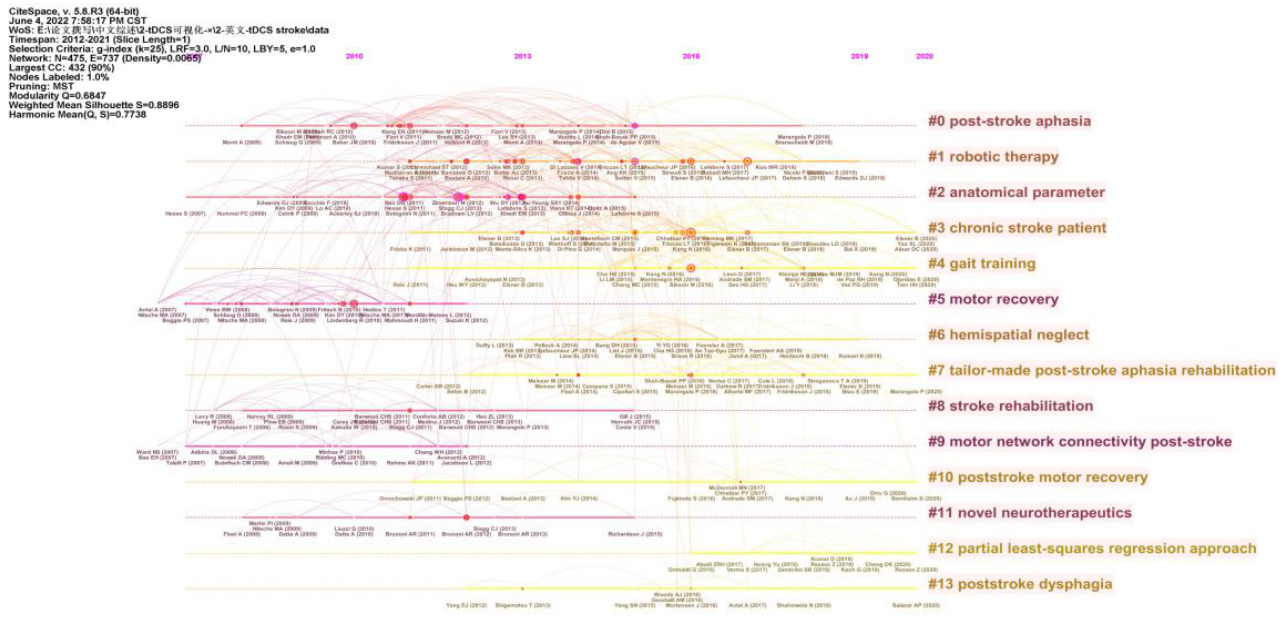
Figure 10. A timeline view of reference cocitation analysis using CiteSpace.